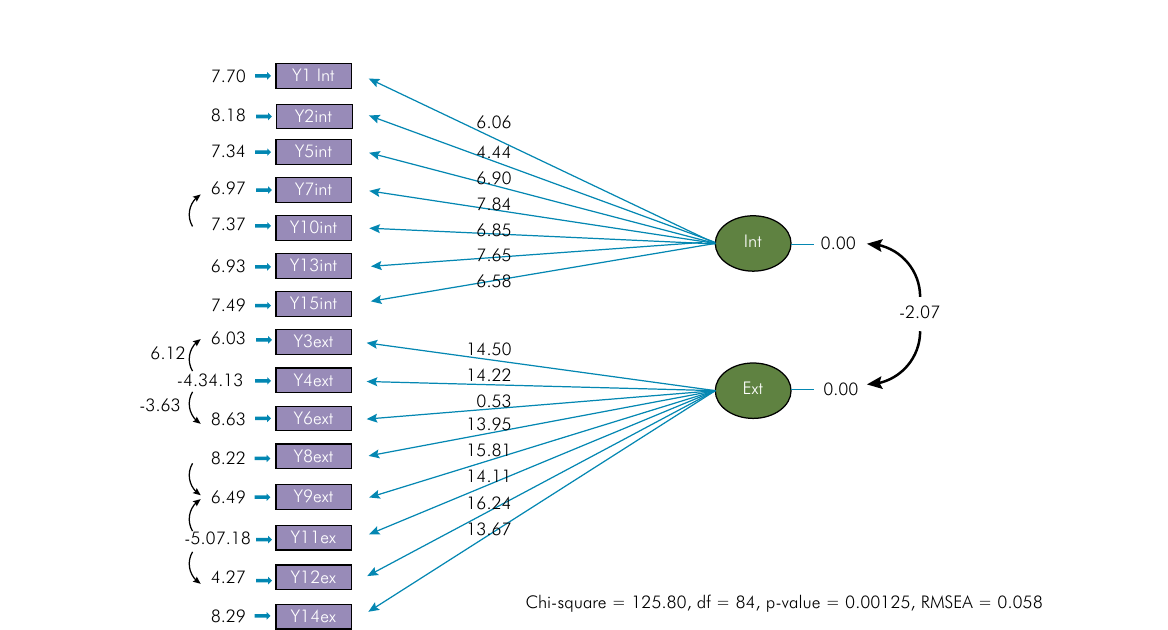
Figure 1. Confirmatory factor analysis results of DTMS cross-cultural